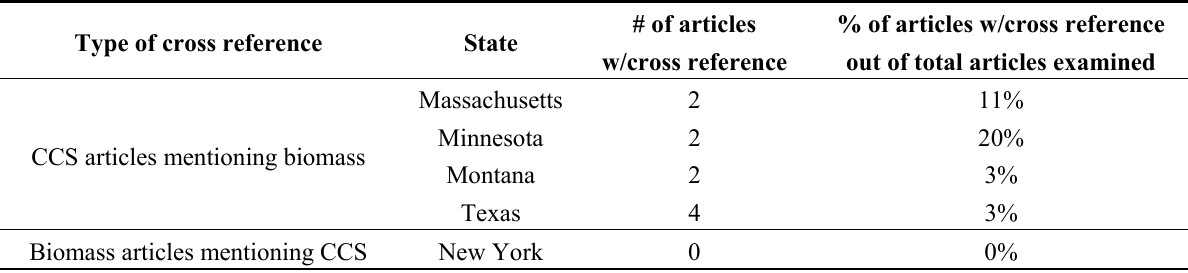
Table 2. Presence of cross references between CCS and